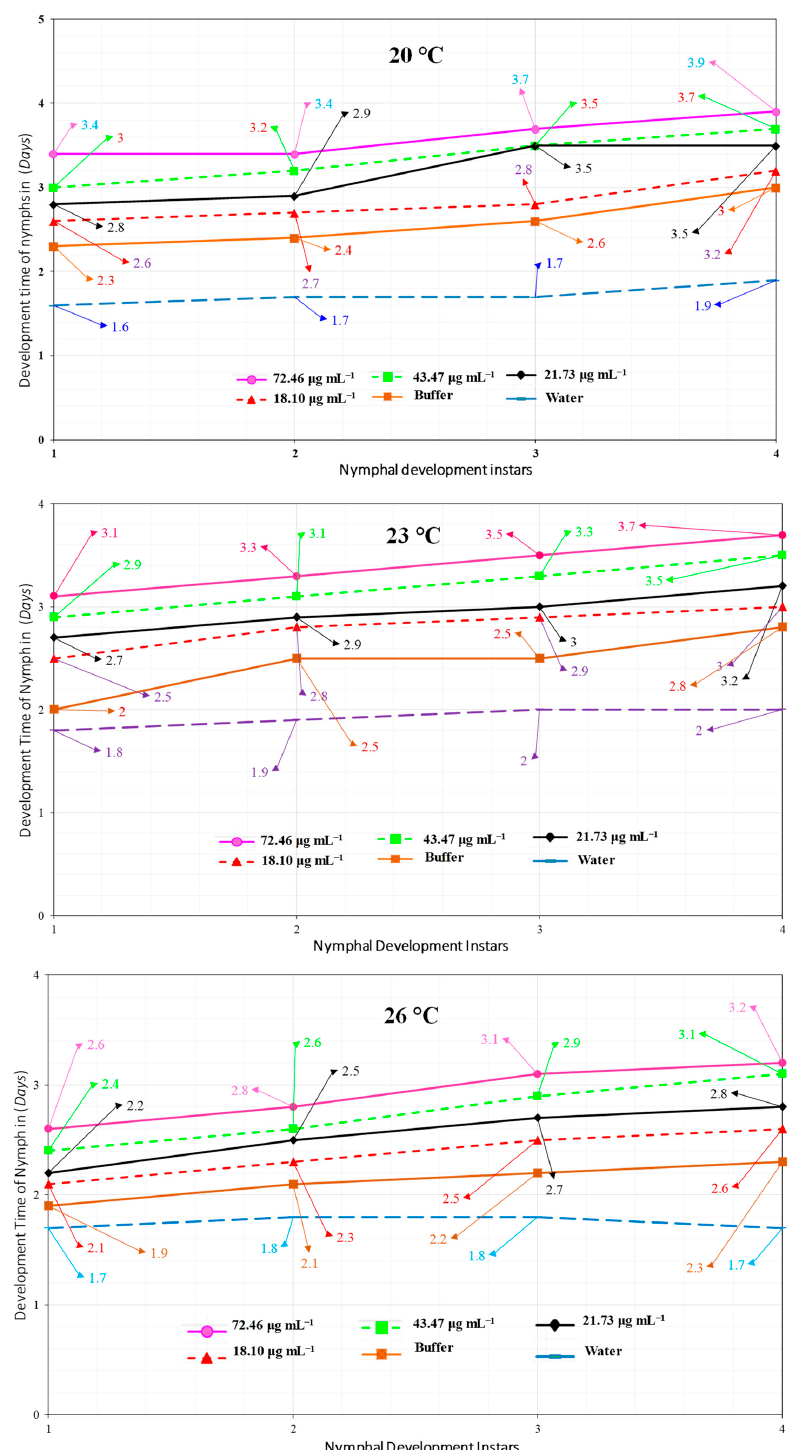
Figure 3. On P. vulgaris plants, the Hrip1 elicitor protein elicited the development of M. japonica nymphs at various doses and temperatures (20, 23, 26 °C) ( n = 10; one-way ANOVA with factorial analysis; LSD at alpha = 0.05). For the fourth nymphal instar development time of 3.9 d at 72.46 µ g mL − 1 and 20 ◦ C, a concentration of 18.10 µ g mL − 1 at 26 ◦ C produced a minimum 1.7 d nymph growth. Aphid fecundity influenced Hrip1 concentrations and temperatures (Figure 4). The experiment found that fecundity was lowest at 26 ◦ C and highest at 23 ◦